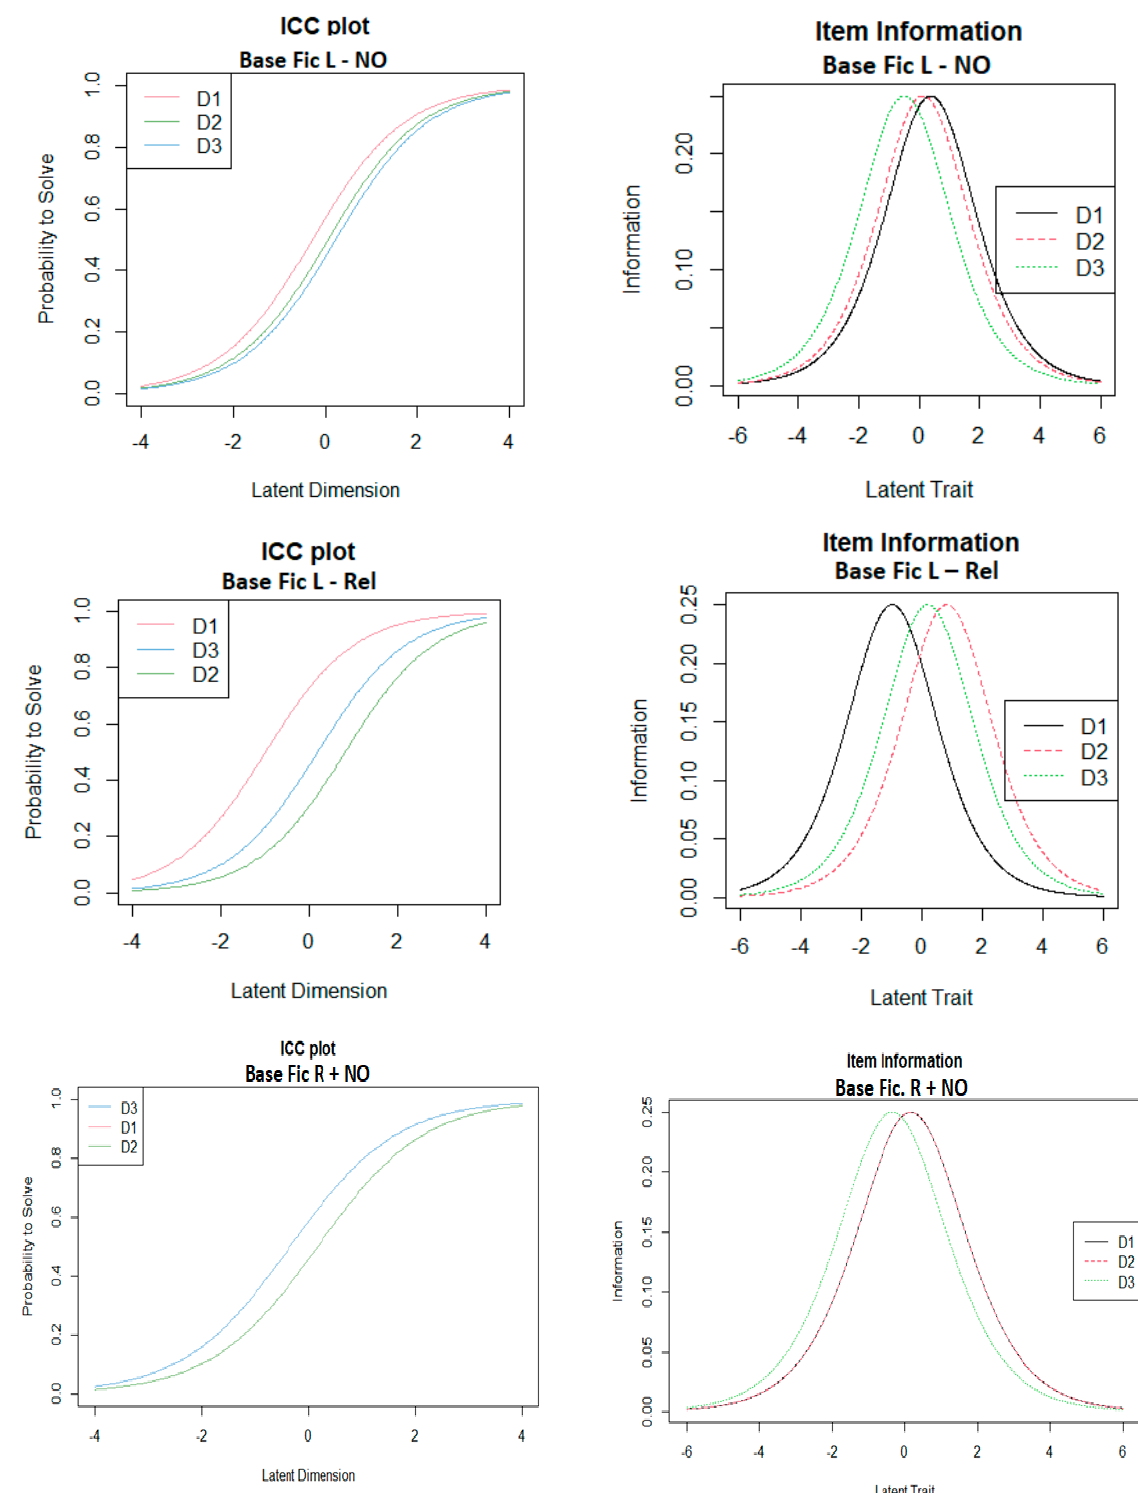
Figure 3. ICC and IIC charts for dichotomous variables